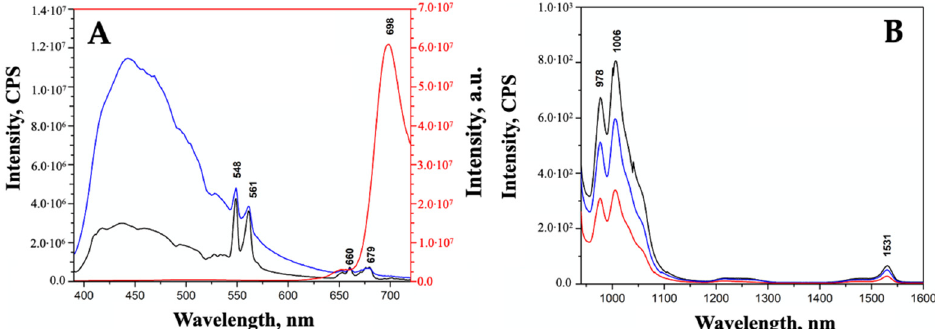
Figure 6. Fluorescence spectra of ZEY2 (curve a, black), ZEY2@SiO 2 (curve b, blue), and ZEY2-Ver (curve c, red) in the Visible region ( A ) upon excitation at 377 nm and in the NIR region ( B ) upon excitation at 910 nm.